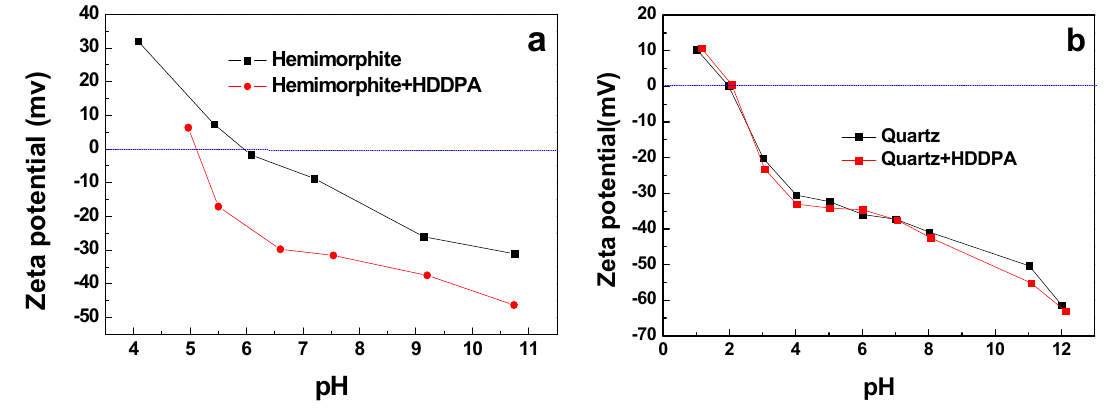
Figure 6. Zeta potential of hemimorphite ( a ) or quartz ( b ) as a function of pH in the absence and presence of 1 × 10 − 4 mol·L − 1 HDDPA.